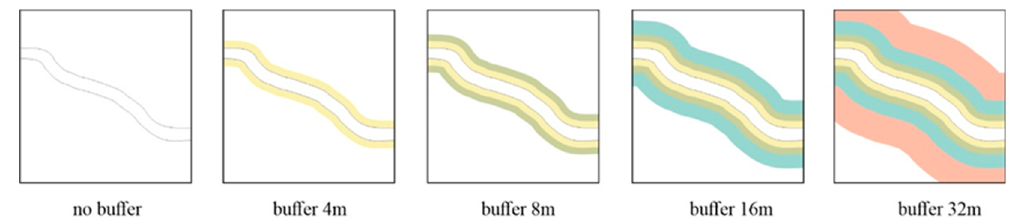
Figure 3. Illustration of buffer zones, where the road width is 3.65 m.